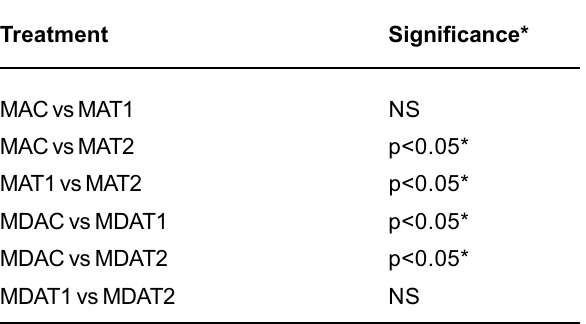
MAC - maxillary arch group C; MDAC - mandibular arch group C; MAT1 - maxillary arch group T1; MDAT1 - mandibular arch group T1; MAT2 - maxillary arch group T2; MDAT2 - mandibular arch group T2; NS: non-significant; *Significant at level of 5% (Student’s t-test).